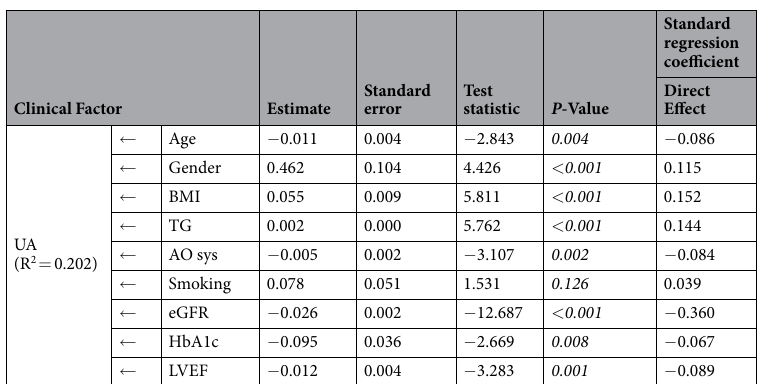
Table 3. The results of path model B. The results (direct effect) of the path model theoretically proposed analysis to identify the clinical factors influencing between each other (see Fig. 2). RMSEA 0.133, AIC 130.0. R 2 : squared multiple correlations. UA, uric acid; BMI, body mass index; TG, triglycerides; AO sys, Systolic blood pressure in the Aorta; eGFR, estimated glomerular filtration rate; HbA1c, hemoglobin A1c; LVEF, left ventricular ejection